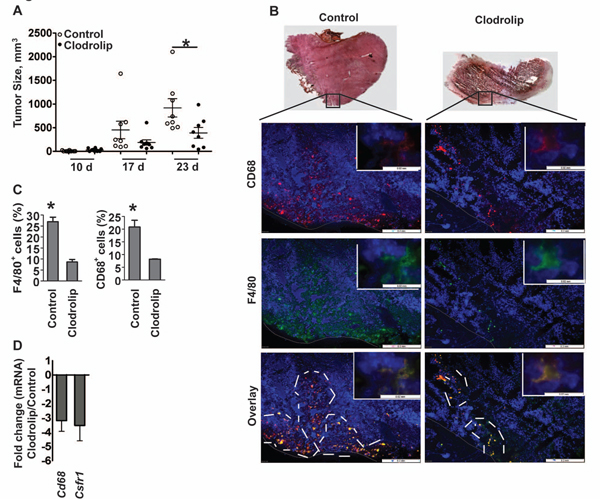
Clodrolip depletes macrophages in F9-teratocarcinoma bearing mice. (A) Size distribution of control and clodrolip tumors at day 10, 17 and 23 after treatment initiation. (B) Upper panel: HE staining of a control tumor section (left) and a clodrolip treated tumor section (right), magnification 2.5×. Note the large necrotic center in the clodrolip treated tumor (right panel). Panels: Immunohistochemical analysis of CD68+ (red) and F4/80+ (green) density in control (left) and clodrolip treated (right) tumors, magnification 10×. Overlay of double-positive macrophages is shown in orange (lower panel); scale bar = 0.2 mm. Macrophage-rich regions are delineated by white lines. Macrophage magnification of 100 × is displayed in each picture at the upper right corner; scale bar = 0.02 mm. Nuclei were stained with DAPI (blue). (C) Quantitative analysis of F4/80+ (left) and CD68+ (right) cell density in control and clodrolip treated tumors; n = 3/group, bars: means ± SEM; *P < 0.05, unpaired t-test. (D) Relative gene expression (mRNA levels) of Cd68 and Csfr-1 in clodrolip treated vs. control tumors; n = 6, bars: means ± SEM.